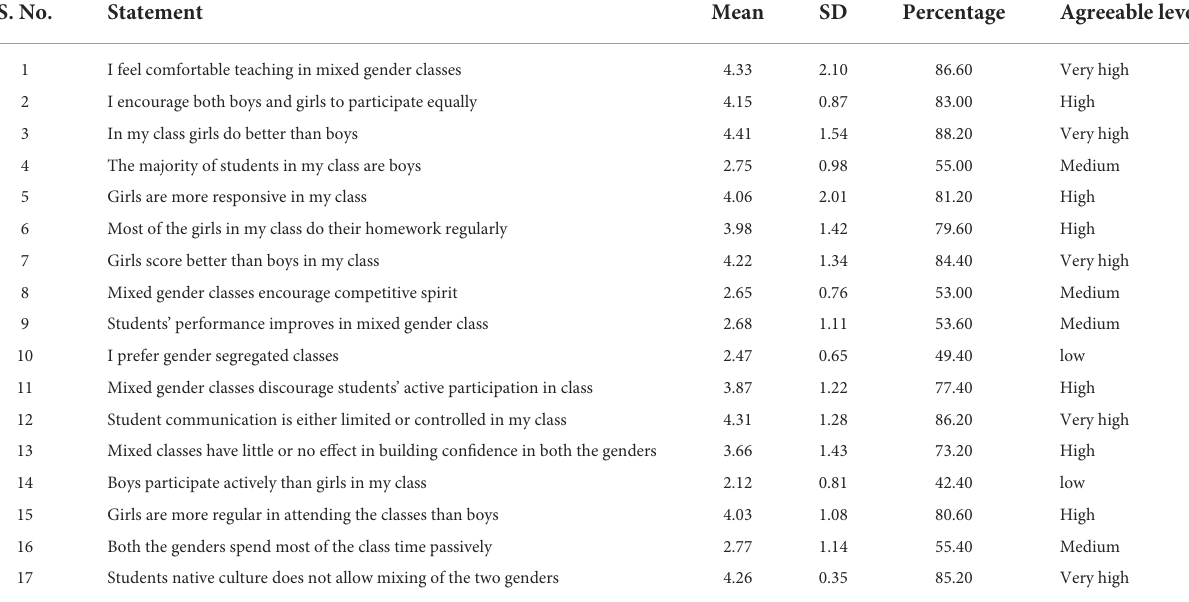
TABLE 2 Responses of teachers on the teachers’